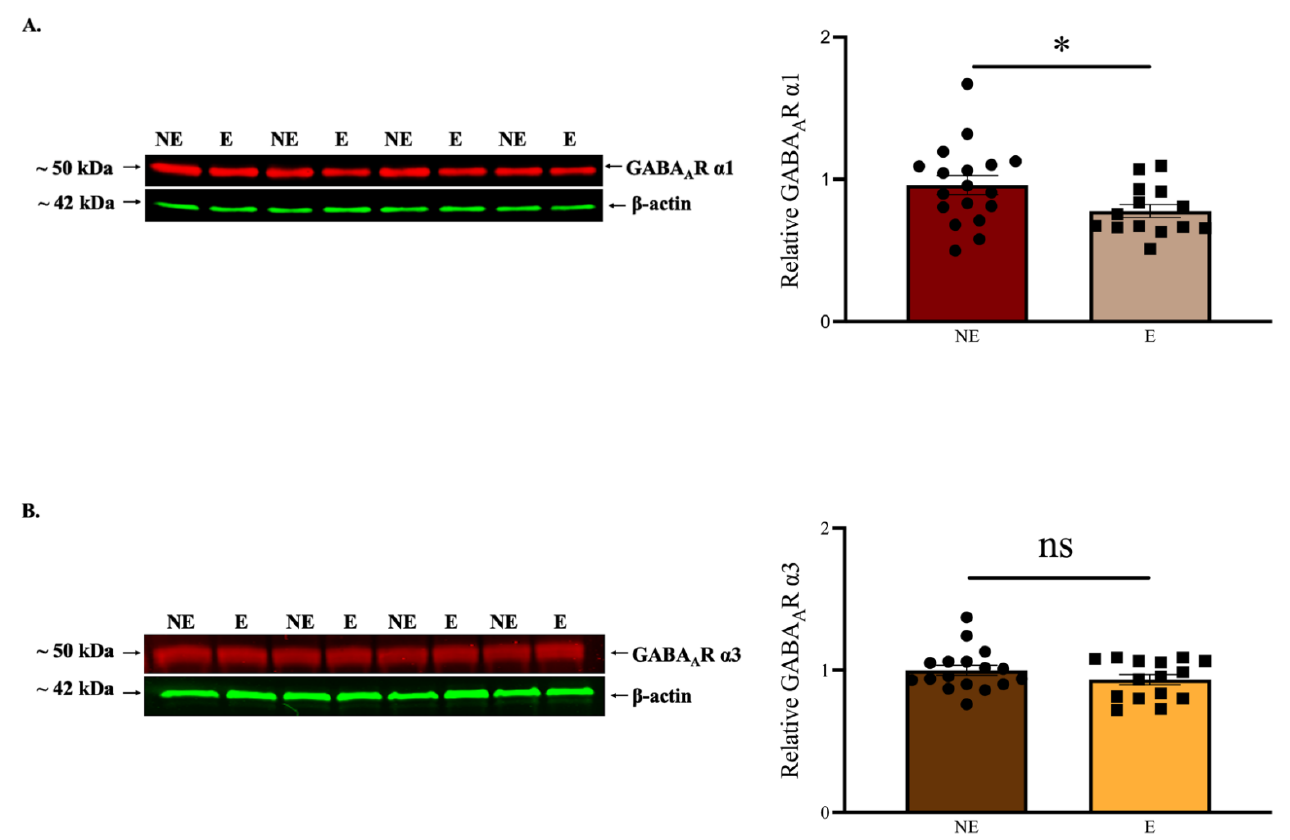
Figure 3. WB analysis for GABA A R α1 and α3 subunits in the primary SoCx. Data compare expression between control (NE) littermates and epileptic (E) stargazers. ( A ) Representative blots display GABA A R α1 in the primary SoCx with β -actin as the loading control. Bar graphs represent the relative expression levels of GABA A R α1 (mean ± SEM). WB analysis revealed a statistically significant reduction in whole-tissue expression levels of GABA A R α1 in the primary SoCx of the stargazers (NE: 0.960 ± 0.066 [ n = 18], E: 0.78 ± 0.046 [ n = 14], p = 0.041); ( B ) Representative blots display GABA A R α3 in the primary SoCx with β -actin as the loading control. Bar graphs represent the relative expression levels of GABA A R α3. There was no statistically significant change in whole-tissue expression levels of GABA A R α3 in the primary SoCx of the stargazers (NE: 1.00 0 ± 0.036 [ n = 17], E: 0.935 ± 0.049 [ n = 15], p = 0.519). The significance threshold was set at 0.05 with * indicating p<0.05. ‘ ns ’ indicates no significant change found from analyses.